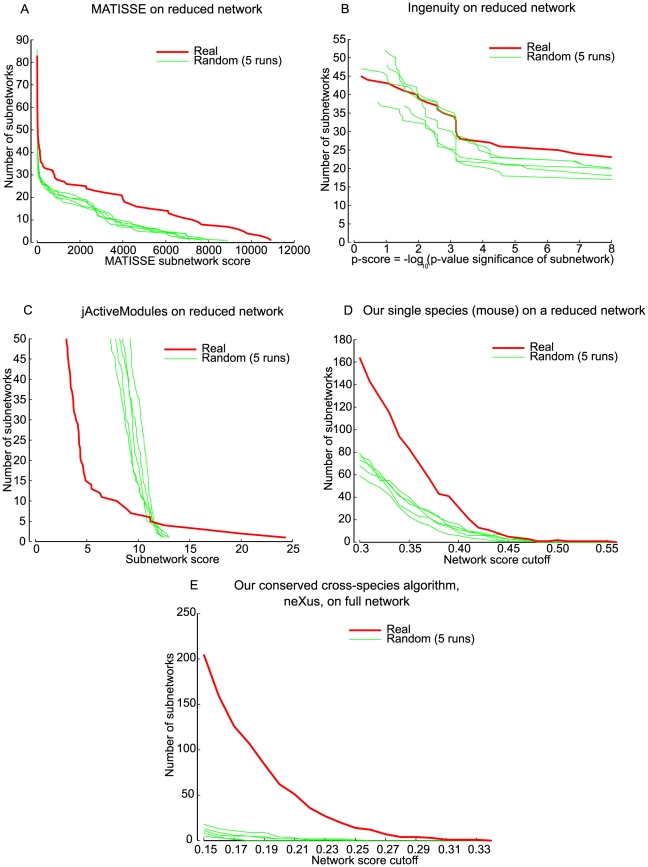
Comparison with other methods.The number of real subnetworks and random subnetworks at various network score cutoffs are plotted for MATISSE (A), Ingenuity (B), jActiveModules (C) and the single-species version of our algorithm (D). The network scores are the metric used by each algorithm to rank the subnetworks. Random subnetworks were obtained by running respective algorithms on the expression data, whose gene labels have been randomly shuffled. Each of the methods uses different forms of the expression data: MATISSE uses expression profiles; jActiveModules uses significance values of the genes; Ingenuity uses focus genes, for which we took any differential expressed gene whose log fold change value was greater (lesser) than 20% of the maximum (minimum) of the most up-regulated (down-regulated) gene; Our method uses fold change scores from the SAM analysis. The scale of the functional linkage network was reduced for all methods shown in (A–D) for a fair comparison. The cross species algorithm on the full network has also been shown for a complete comparison (E).